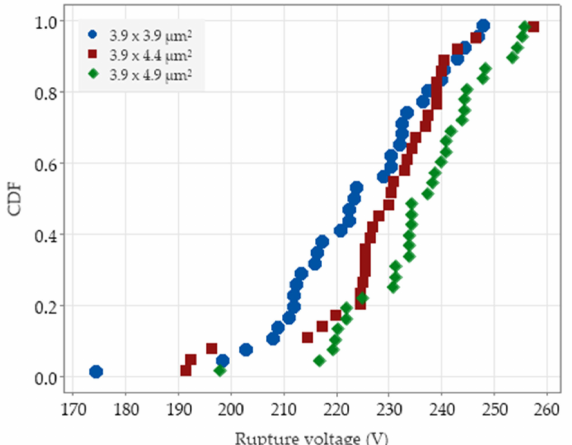
Figure 7. Cumulative distribution functions of the voltage at stopper failure, for the three considered sizes reported in the